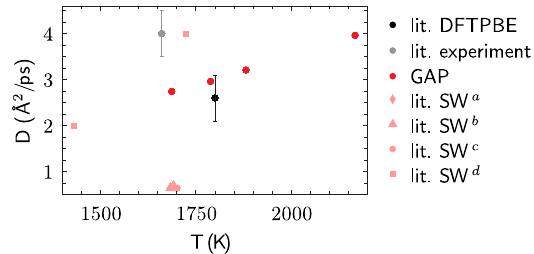
FIG. 8. Diffusivity of liquid silicon from literature DFT simulations [181] (black), literature experiment [180] (gray), GAP (red), and literature SW potential [Refs. [182 – 185] for (a) – (d), respectively, pink]. Error bars for GAP simulations are smaller than symbols on this scale and are not available for literature SW